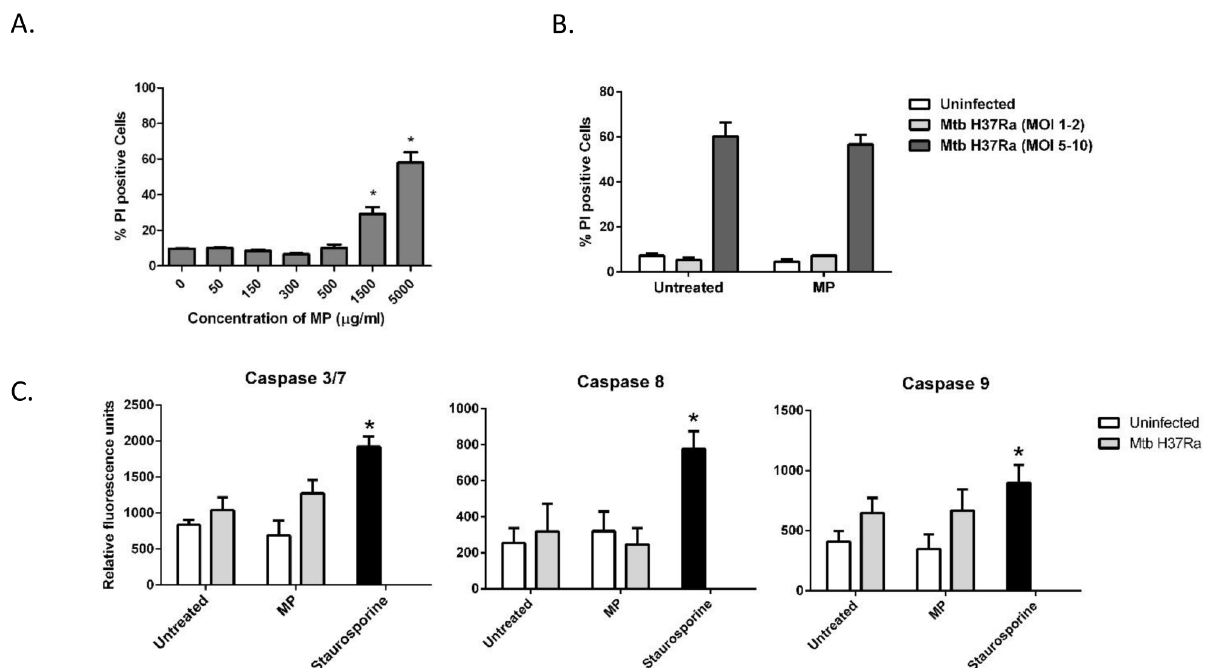
Fig 2. The effect of MPs on cell death and caspase activity in the presence or absence of Mtb infection. (A) PMA-differentiated THP-1 cells were treated with PLGA MPs at the indicated doses for 1 hour. The cells were washed to remove extracellular MPs and incubated for a total of 24 hours at 37°C, 5% CO 2. Cell death was measured by propidium iodide exclusion assay and automated fluorescence microscopy. (B) THP-1 cells were uninfected or infected with Mtb (H37Ra) to reach an MOI of 1 – 5 phagocytosed bacilli per cell, washed and treated with 2.2 μ m PLGA MPs for 1 hour at 37°C, 5% CO 2 after which the cells were washed and incubated for a total of 24 hours. Cell death was measured as above. (C) In parallel experiments cell lysates were assayed for caspase activity using caspase substrates coupled to AMC and proteolytic cleavage of the substrates was measured on a microplate reader (Ex/ Em = 360/460nm). Staurosporine (0.4 μ g/ml) was used as a positive control for apoptosis. Results are expressed as arbitrary fluorescence units (mean +/- SEM) and are representative of 3 independent experiments, * p < 0.05 compared to uninfected cells.